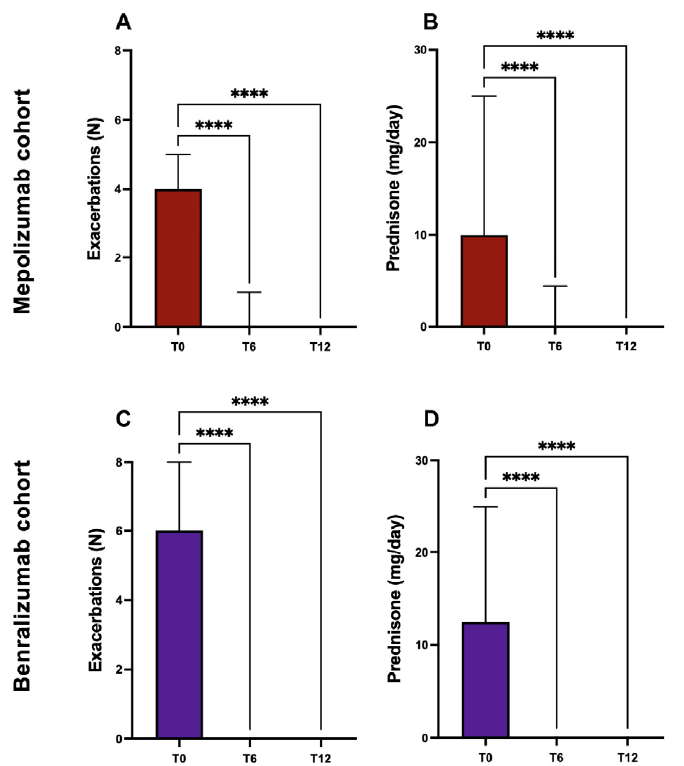
Figure 3. Effects of mepolizumab ( panels A,B ) and benralizumab ( panels C,D ) on exacerbations and OCS mean daily dose (****: p < 0.0001).